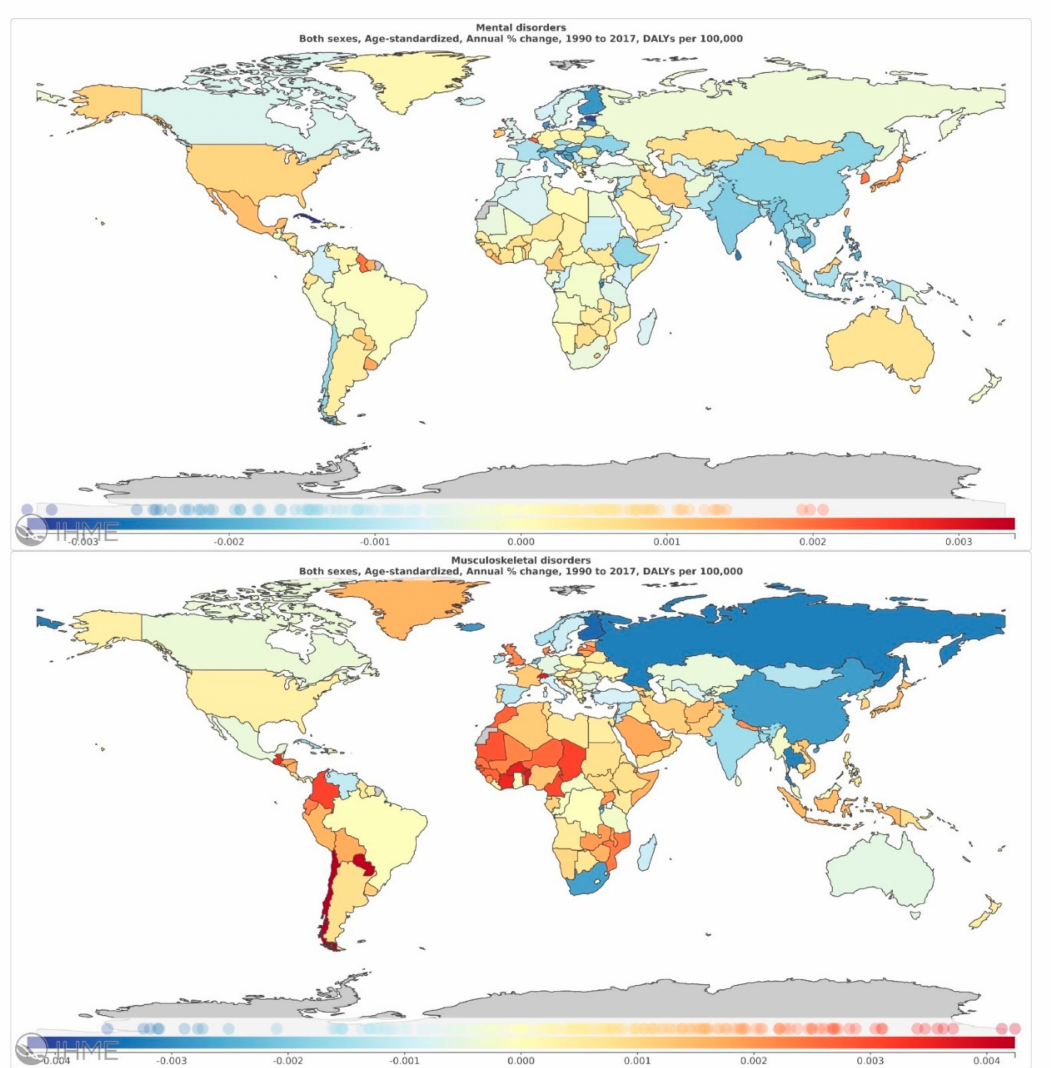
Figure 1. Annualized rate of change (ARC%) of age-standardized total mental disorders (MDT) and musculoskeletal DALYs rate, in both sexes, between 1990 and 2017. Map was generated using the GBD visualization tool provided online by the Institute of Health Metrics and Evaluation (https: // vizhub.healthdata.org / gbd-compare /